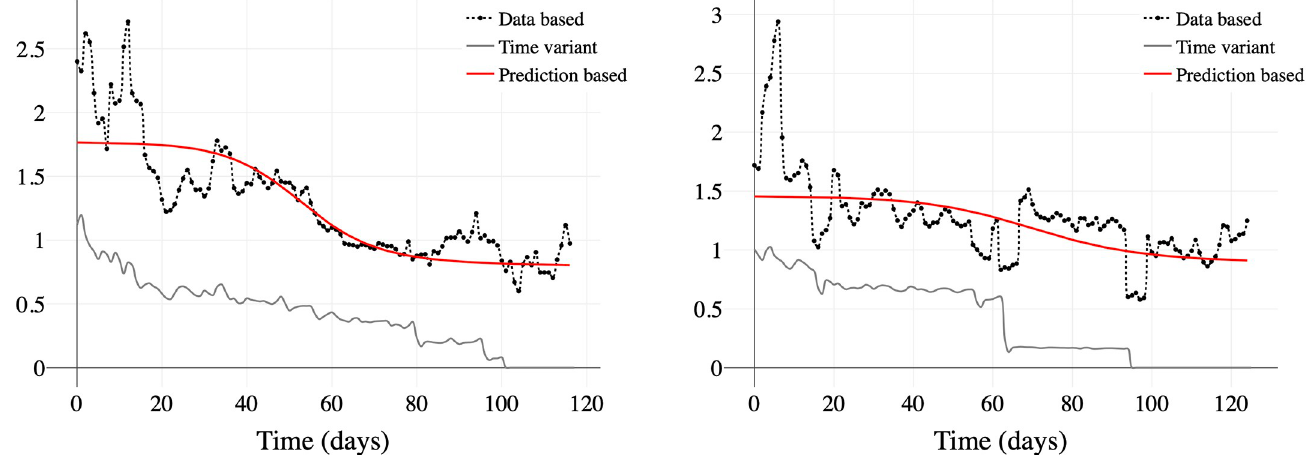
Fig 8. Comparison of standard scaled R from different estimate algorithms. (a) Maranh ã o estimated R(t). (b) S ã o Paulo estimated R(t). t